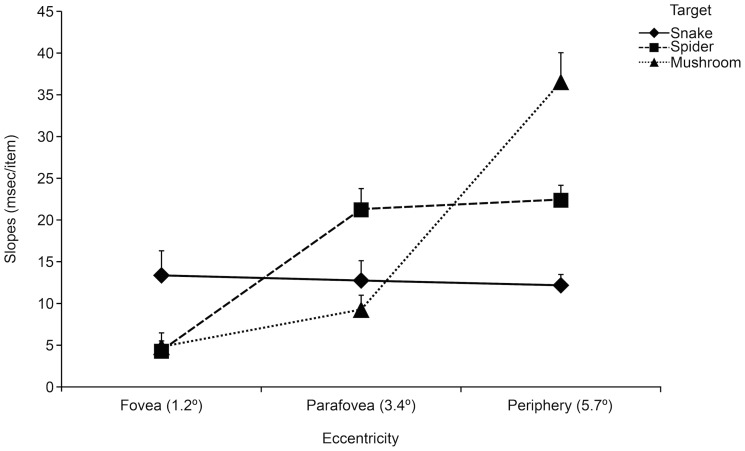
Experiment 2: Attentional efficiency reflected in slopes across different set sizes (3, 6, 12, 18) (expressed as the mean search time [in milliseconds]/searched item) for locating the target picture (snake, spider, mushroom) as a function of eccentricity (fovea, parafovea, periphery).